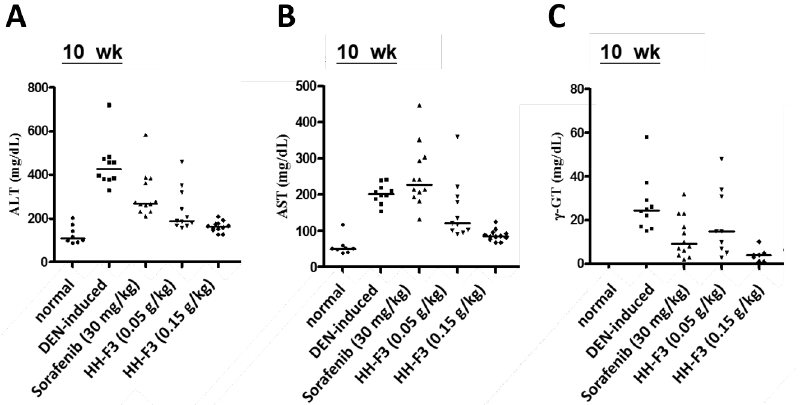
Figure 5. In vivo e ff ects of HH-F3 on diethylnitrosamine (DEN)-induced liver fibrosis increases in serum biomarkers. The rats were divided into five groups: group 1, normal control (no treatment); group 2, model group (DEN operation); group 3, sorafenib (30 mg / kg) and DEN-treated group; group 4, HH-F3 (0.05 g / kg) and DEN-treated group; group 5, HH-F3 (0.15 g / kg) and DEN-treated group. ( A ) Serum alanine aminotransferase (ALT), ( B ) aspartate aminotransferase (AST), and ( C ) γ -glutamyltransferase ( γ -GT) levels in mice. Levels of serum ALT, AST, and γ -GT were significantly decreased to nearly the normal level after antifibrosis treatment with high-dose